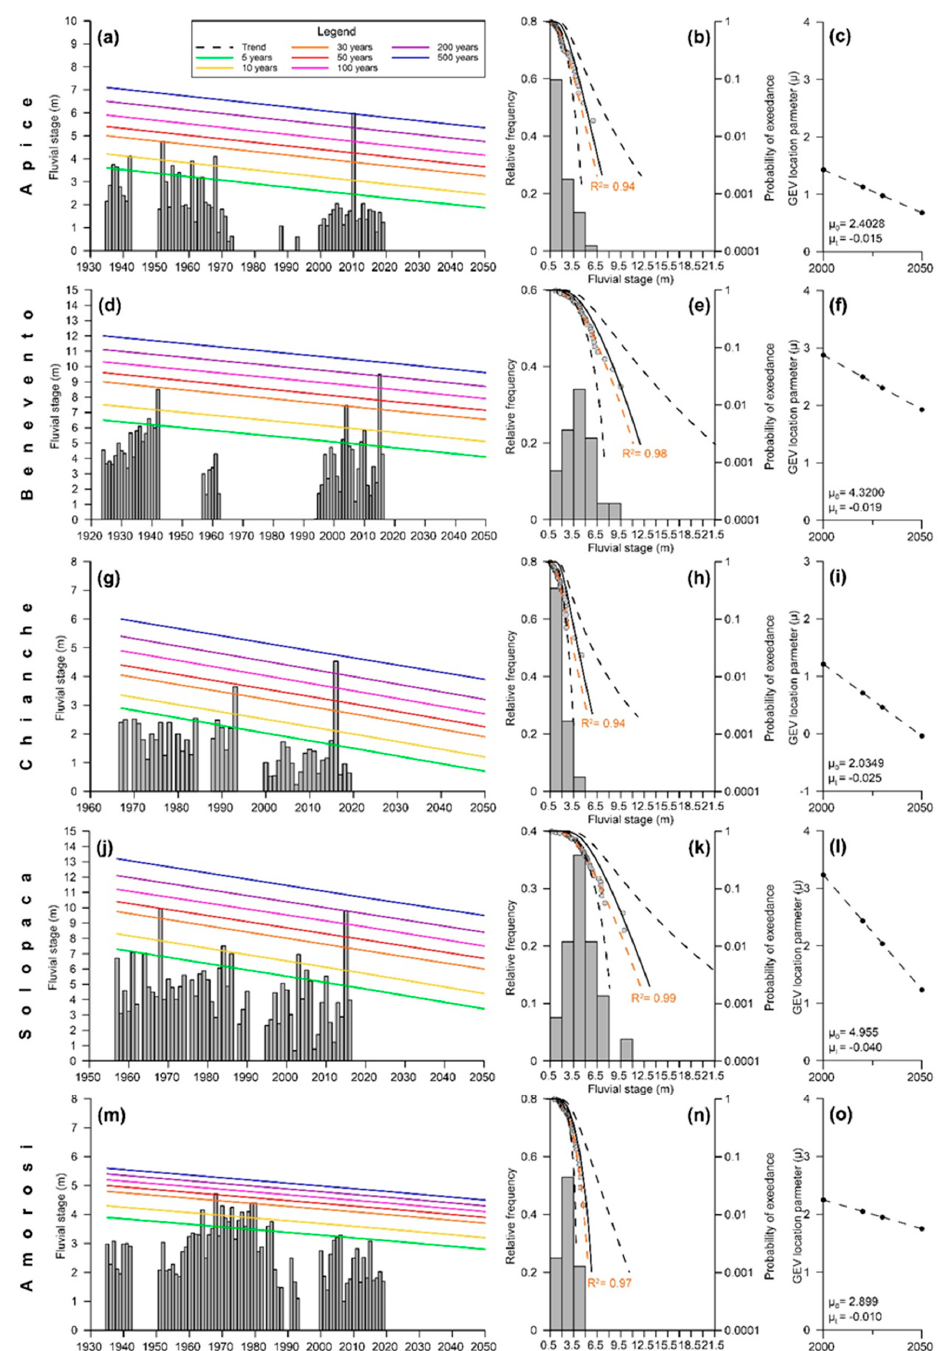
Figure 2. Time series ( a , d , g , j , m ) recorded at hydrometric stations considered for the analysis, nonstationary Generalized Extreme Values (GEV) probability models ( b , e , h , k , n ) indicating initial conditions (i.e., µ = µ 0 ) and best fit condition (such that R2~max; i.e., µ = µ 0 + µ t × sample size/2) and variation in time (years) of the location parameter of the nonstationary GEV models ( c , f , i , l , o ). Dark dashed lines of GEV models graph depict 95% confidence interval and provides an overview of the uncertainty associated to estimated flood magnitude at specific return period in the initial condition (i.e., µ = µ 0 ). As expected, low frequency flood has much significant uncertainty associated to magnitude estimation.